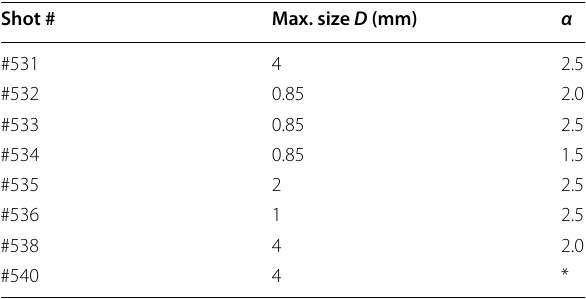
Table 2 Target conditions, α , and D , for each shot